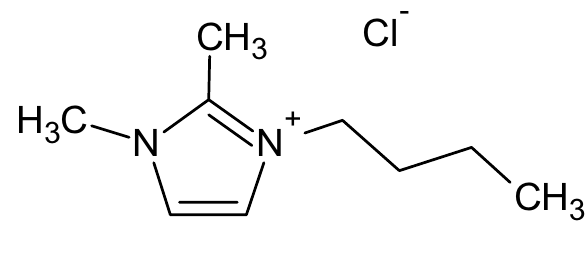
Fig. 1 Chemical structure of